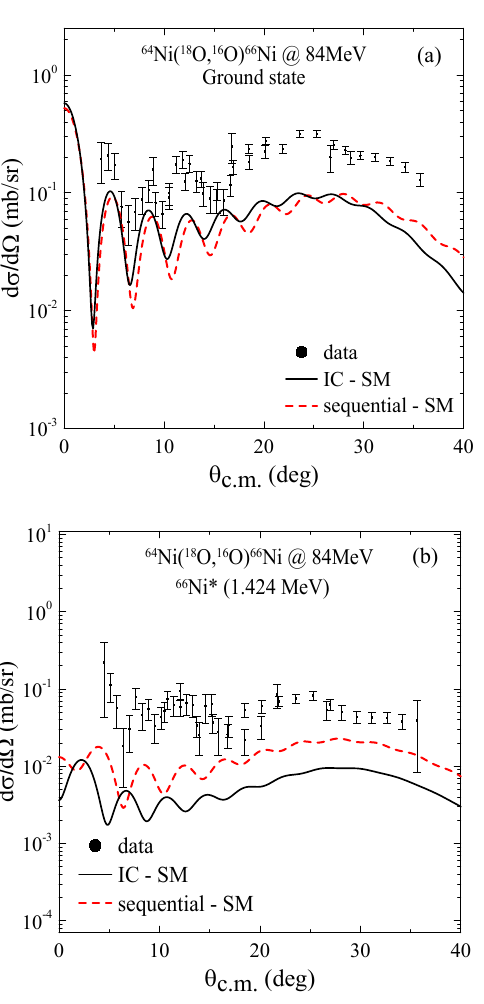
Fig. 3. Comparison of the experimental data and theoretical results corresponding to the 64 Ni( 18 O, 16 O) 66 Ni. IC means independent coordinates CRC calculations. Sequential stands for the sequential CCBA calculations. SM means that the spectroscopic amplitudes are derived from shell-model